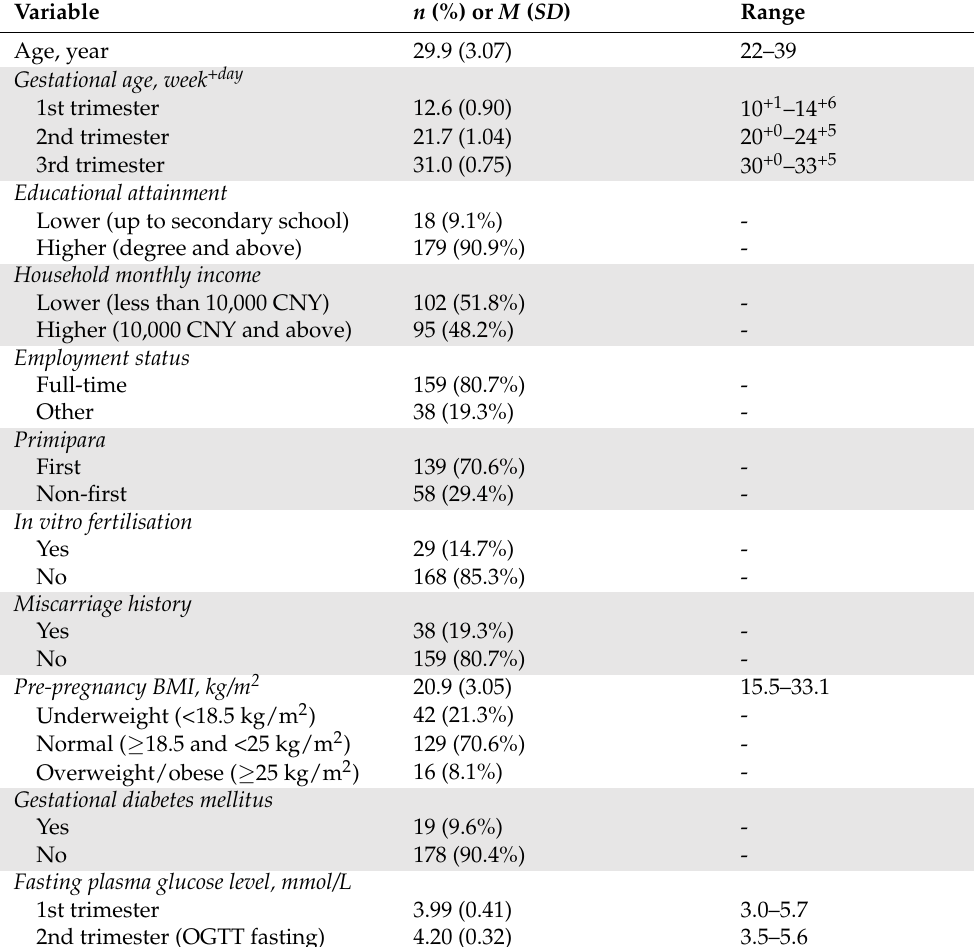
Table 1. Sample characteristics of pregnant women ( N =